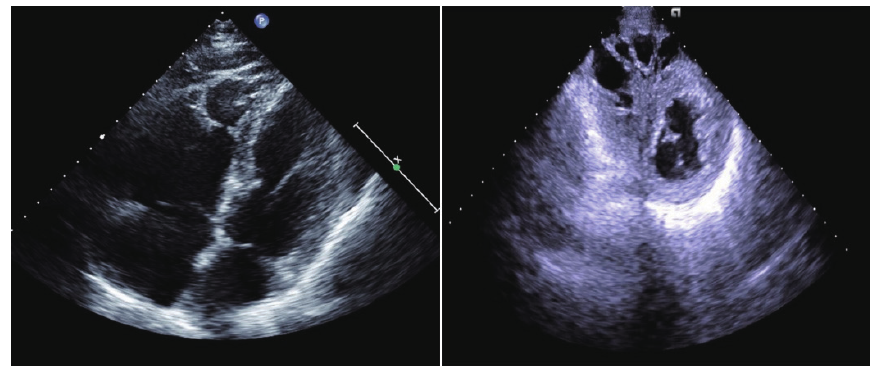
Figure 7 Arrhythmogenic cardiomyopathy. Enlargement of right atrium and ventricle with obvious muscular trabeculae echo in RVOT muscular part and right ventricular apex and relatively thinner wall thickness of right ventricle.